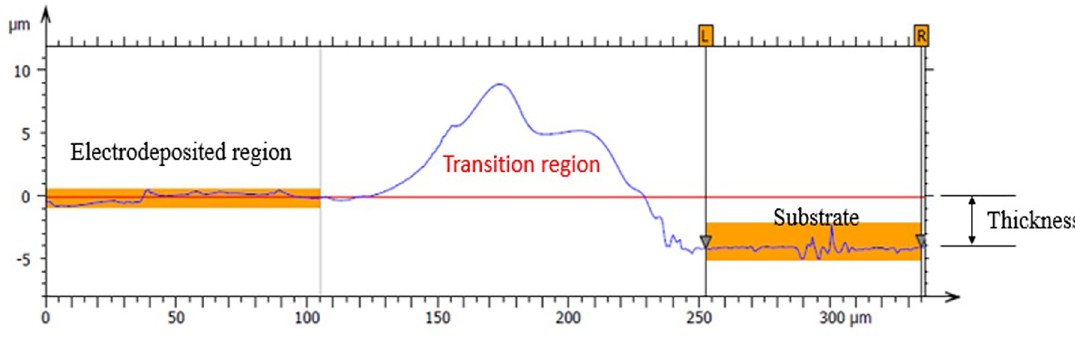
Figure 2. Determination of the thickness in the sample 6.